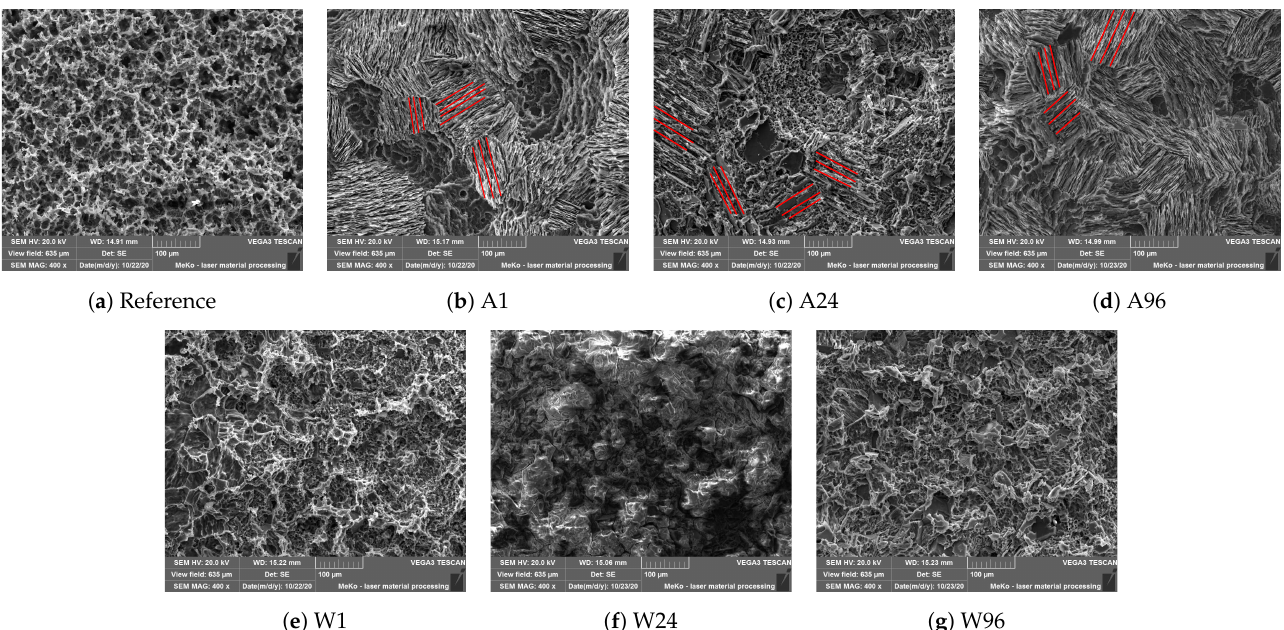
Figure 6. SE images of the platelets after potentiodynamic polarisation in dependence of the heat treatment duration and the cooling condition. All platelets are shown in longitudinal section. ( b – d ) feature strongly aligned structures (marked in red).